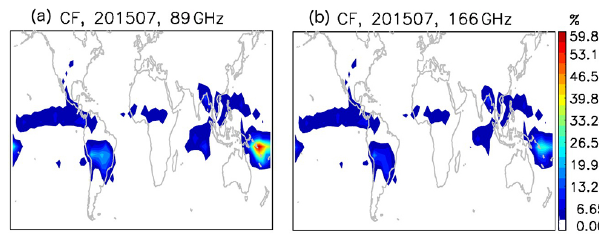
Figure D1. Cloudy-sky cloud occurring frequency (CF) by apply- ing the 3 σ method from the GMI’s 89 and 166GHz observations during July